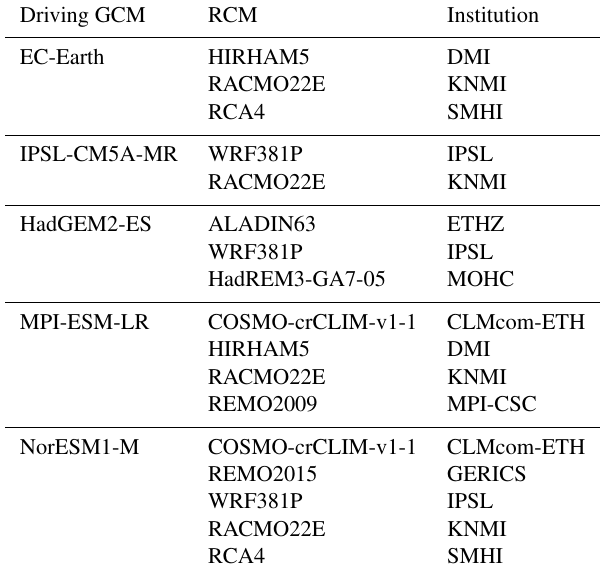
Table 1. The RCM simulations used in this study. The first col- umn indicates the driving global climate model; the second indi- cates the regional climate model; and the third indicates the insti- tution that conducted the simulations, using model and institution acronyms at https://esgf-data.dkrz.de/search/cordex-dkrz/ (last ac- cess: 2 April